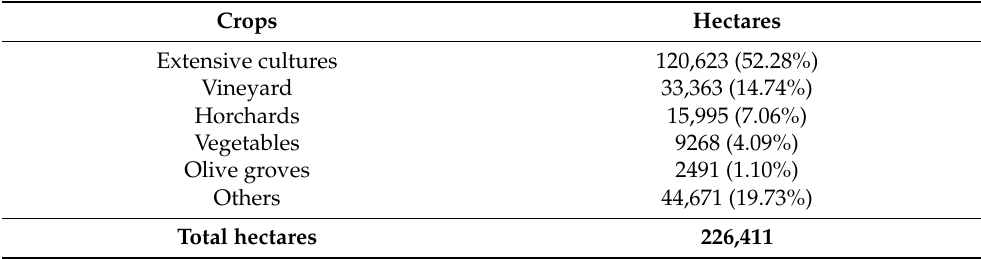
Table 1. Main crops and hectares farmed in the sampled area. In brackets, the percentage of total cropped hectares is specified. Data were obtained from